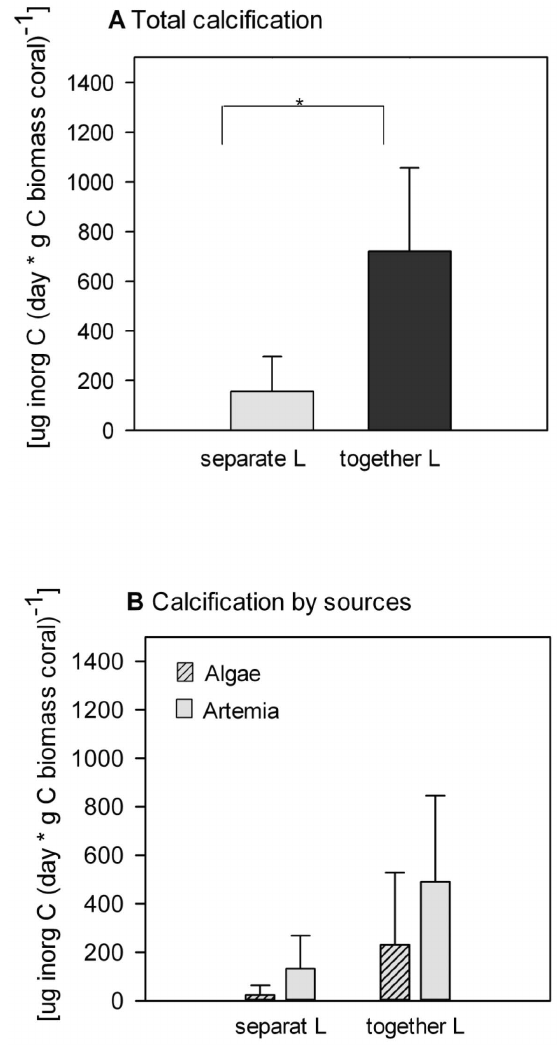
Figure 3. Respiration by E.norvegica (E) and L.pertusa (L.). a) Total tracer C respiration, b) tracer C respiration separated by food substrate (algae, Artemia ). Animals were incubated separate or together in one chamber; statistical significance between treatments is indicated as followed: **p , 0.009, *p , 0.05, ? 0.05 , p , 0.06. The bars in each figure represent average 6 SD.